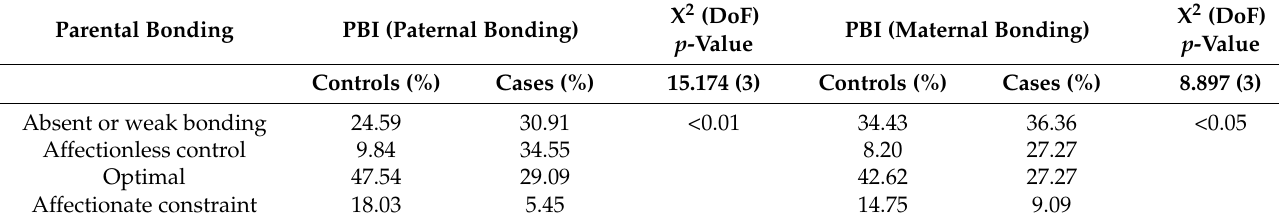
Table 1. Chi-Squared test PBI bonding.